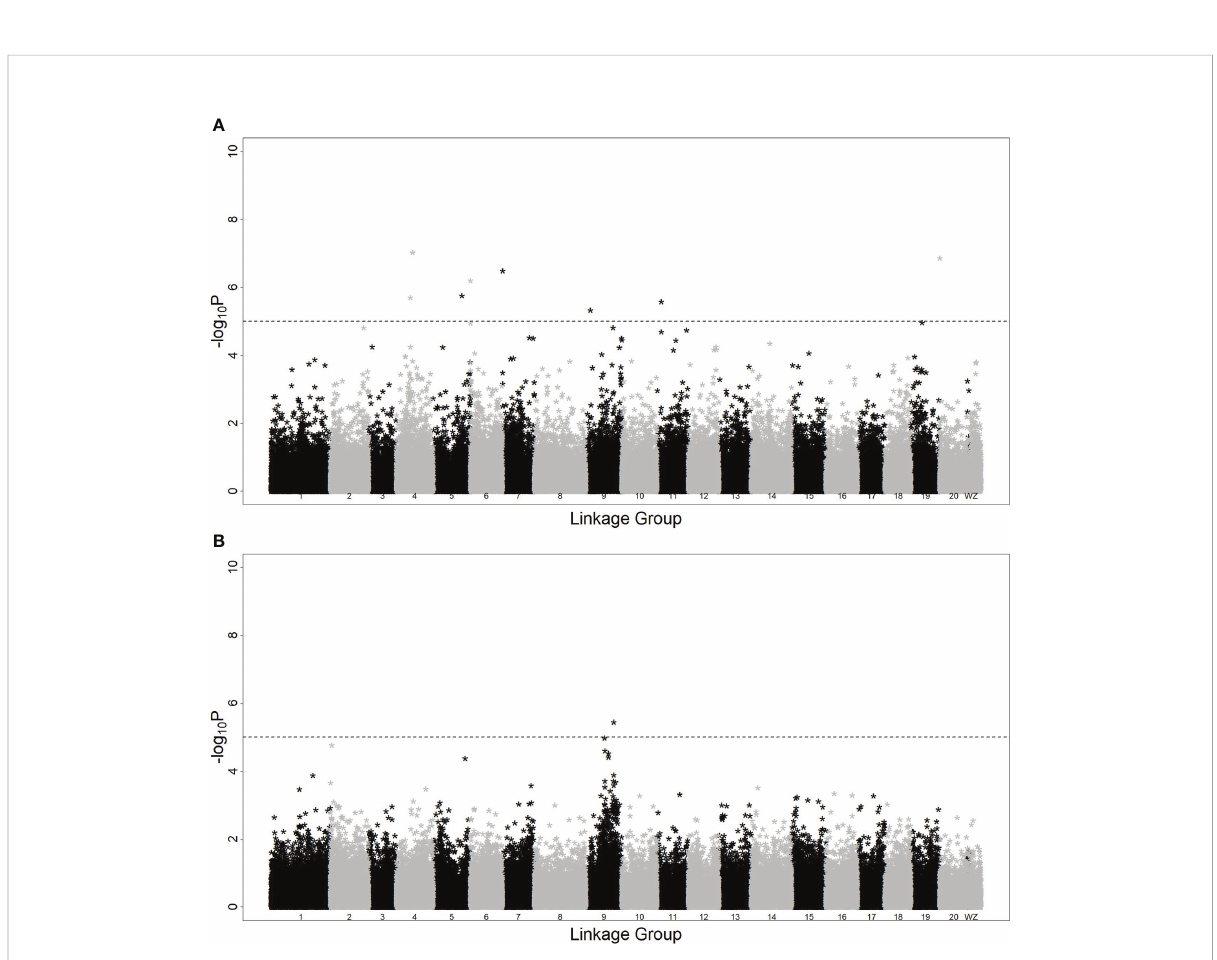
FIGURE 2 Genome-wide association study of hypermelanosis of Chinese tongue sole. (A) : hypermelanosis area; (B) : hypermelanosis incidence *:the negative logarithm of P-values at the corresponding